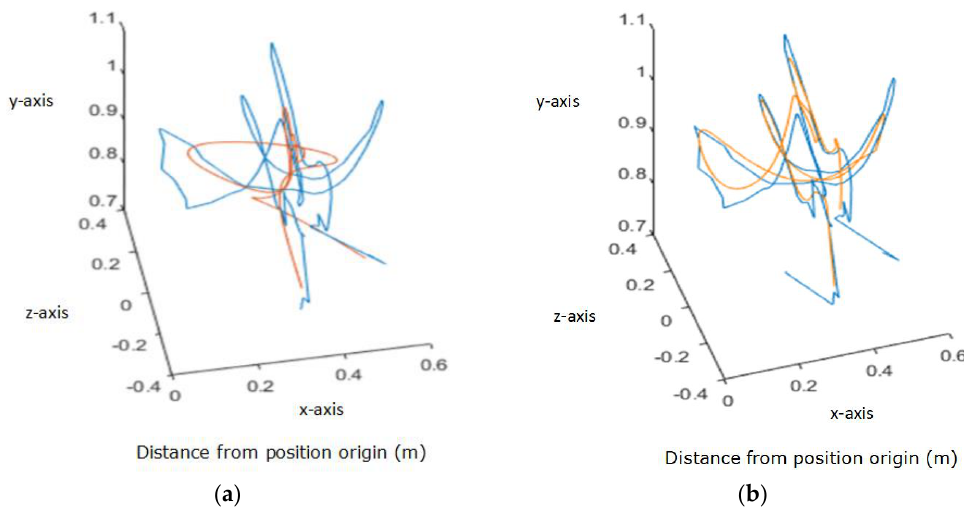
Figure 2. In blue, the original 3D trajectory of a participant’s right hand as they perform a “conducting” gesture, tracked using a Microsoft Kinect. ( a ) Motion learning reproduction without segmentation and fusion. ( b ) Reproduction after trajectory segmentation and fusion, using 90 point segments with a 20 point overlap.